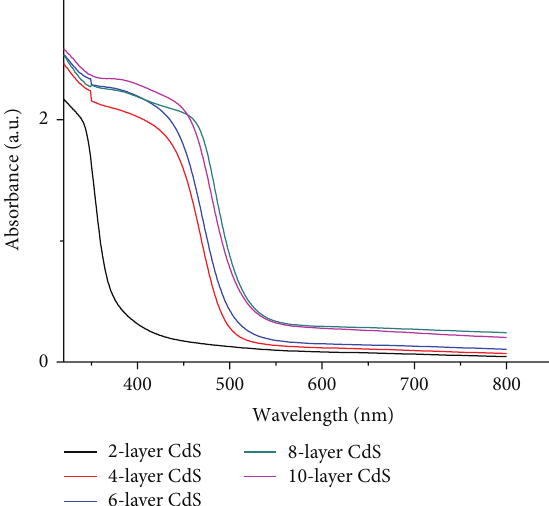
Figure 2: The absorbance spectra of CdS/TiO 2 films in the visible region.